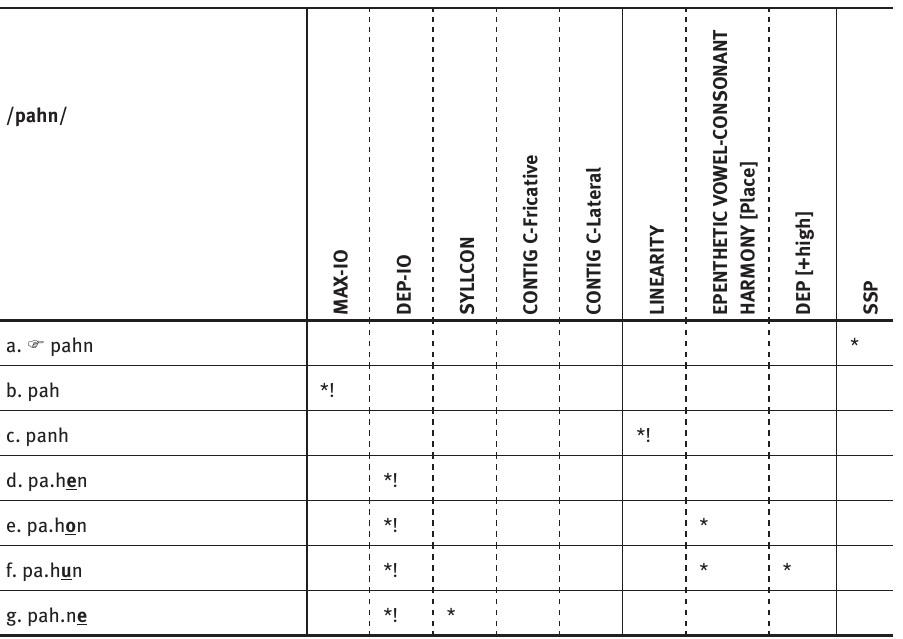
Table 15 : MAX-IO, DEP-IO, SYLLCON, CONTIG C-Fricative, CONTIG C-Lateral >>LINEARITY, EPENTHETIC